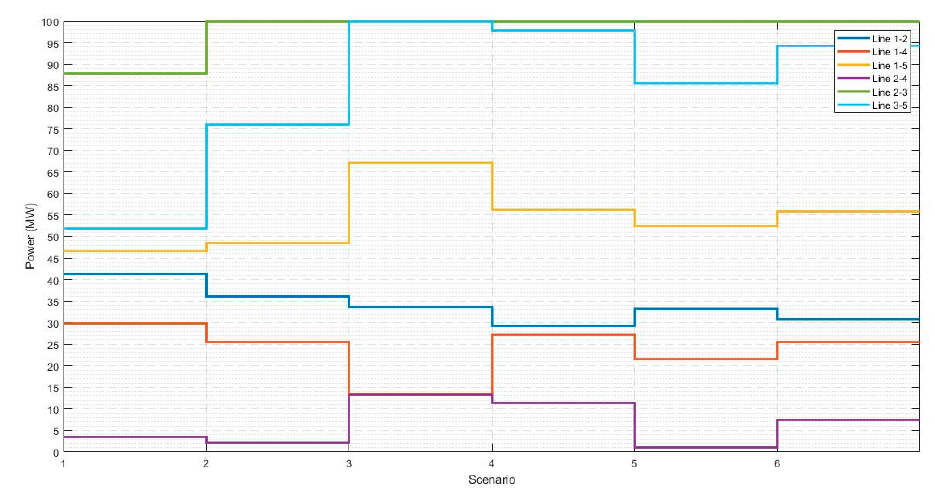
Figure 6. Power flow, without expansion. 2 Table 11. Summary of results of case study